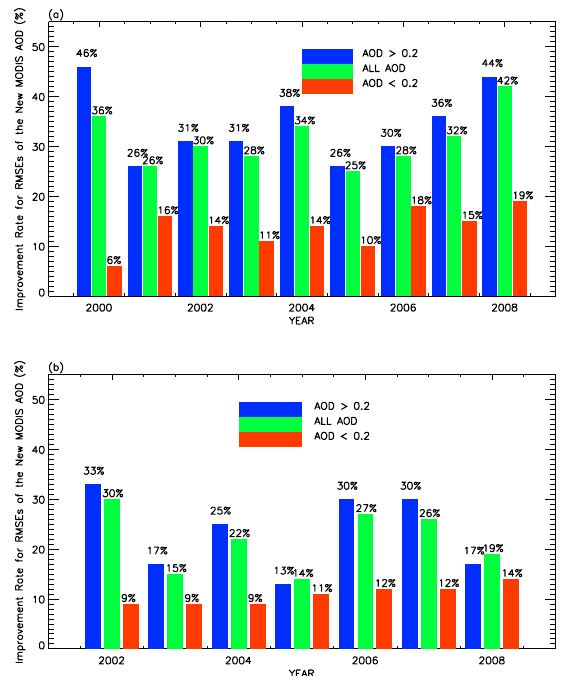
Fig. 9. The percentages of improvements for the RMSEs between MODIS AOD and AERONET AOD at 0.55µm before and after cor- rections, for all data (green), data with MODIS AOD greater than 0.2 (blue), and data with MODIS AOD smaller than 0.2 (red). (a) for Terra 2000–2008, (b) for Aqua